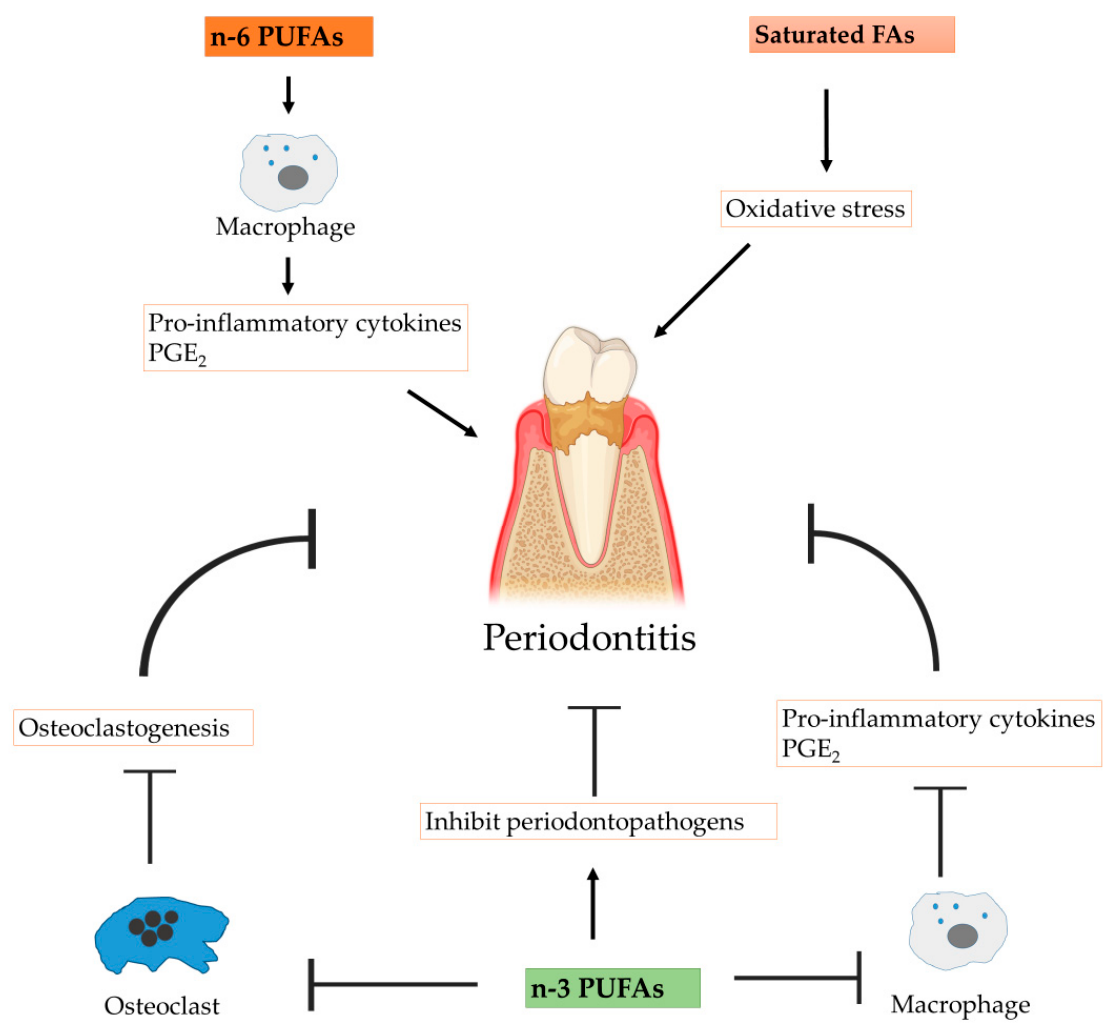
Figure 3. Implications of fatty acids in